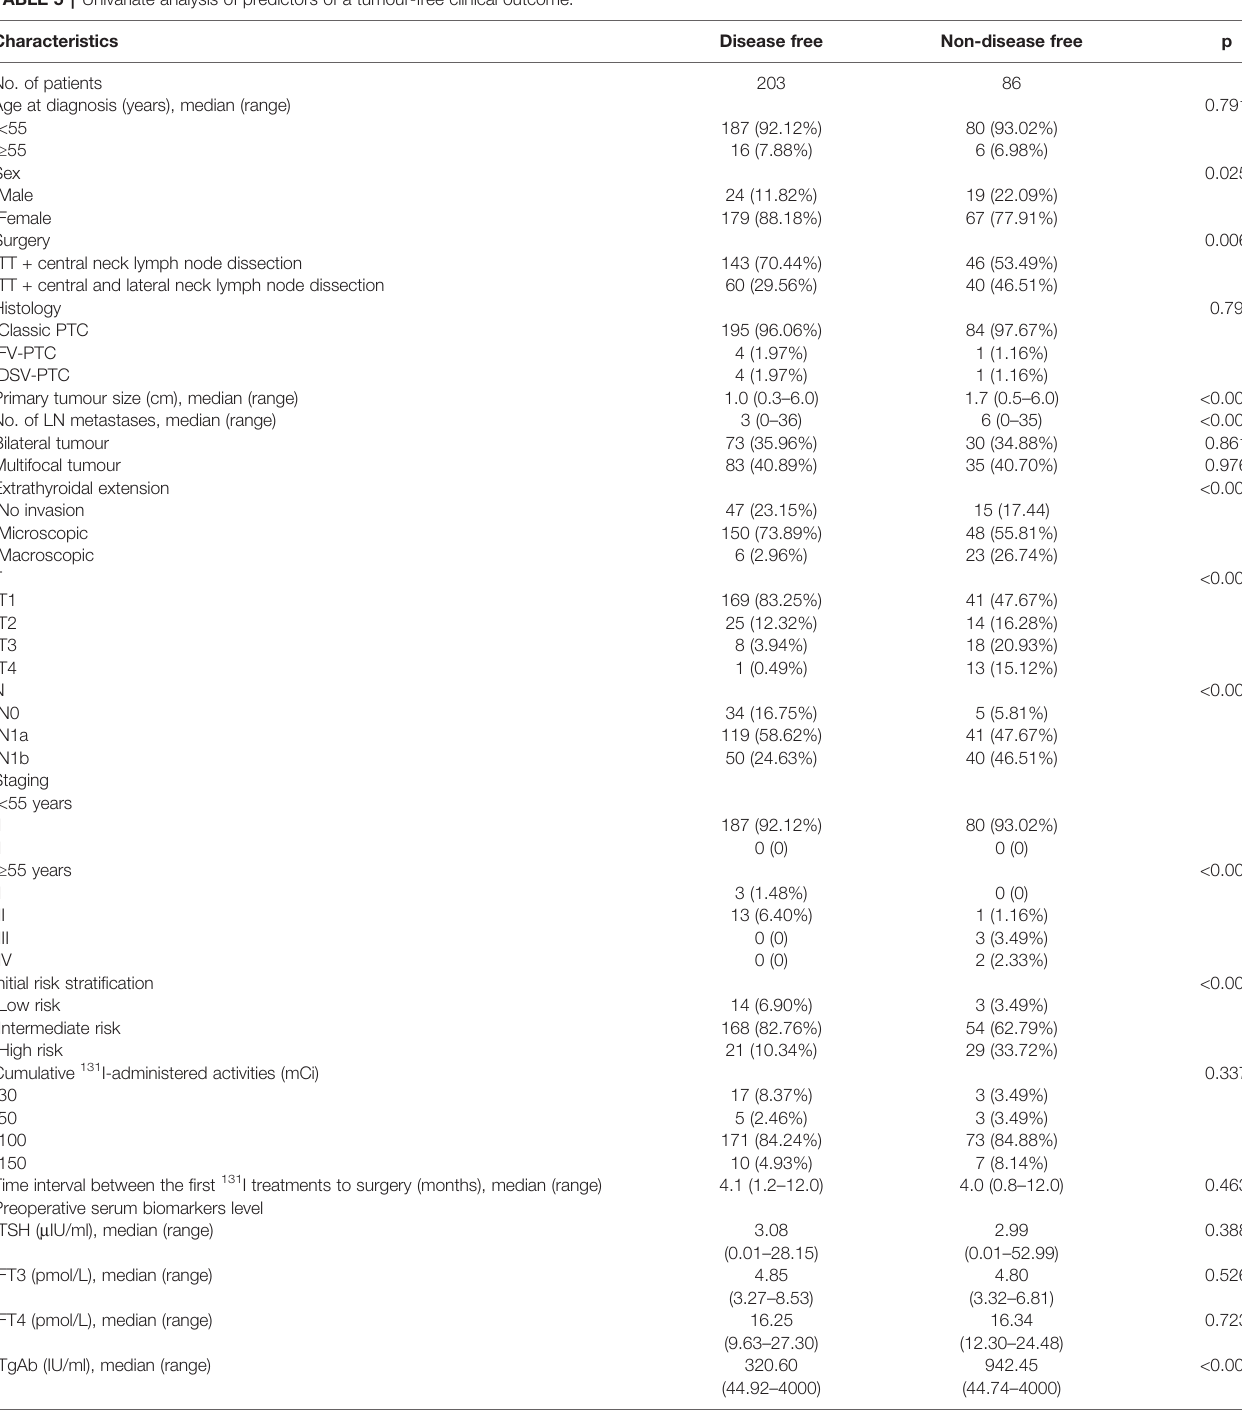
TABLE 5 | Univariate analysis of predictors of a tumour-free clinical